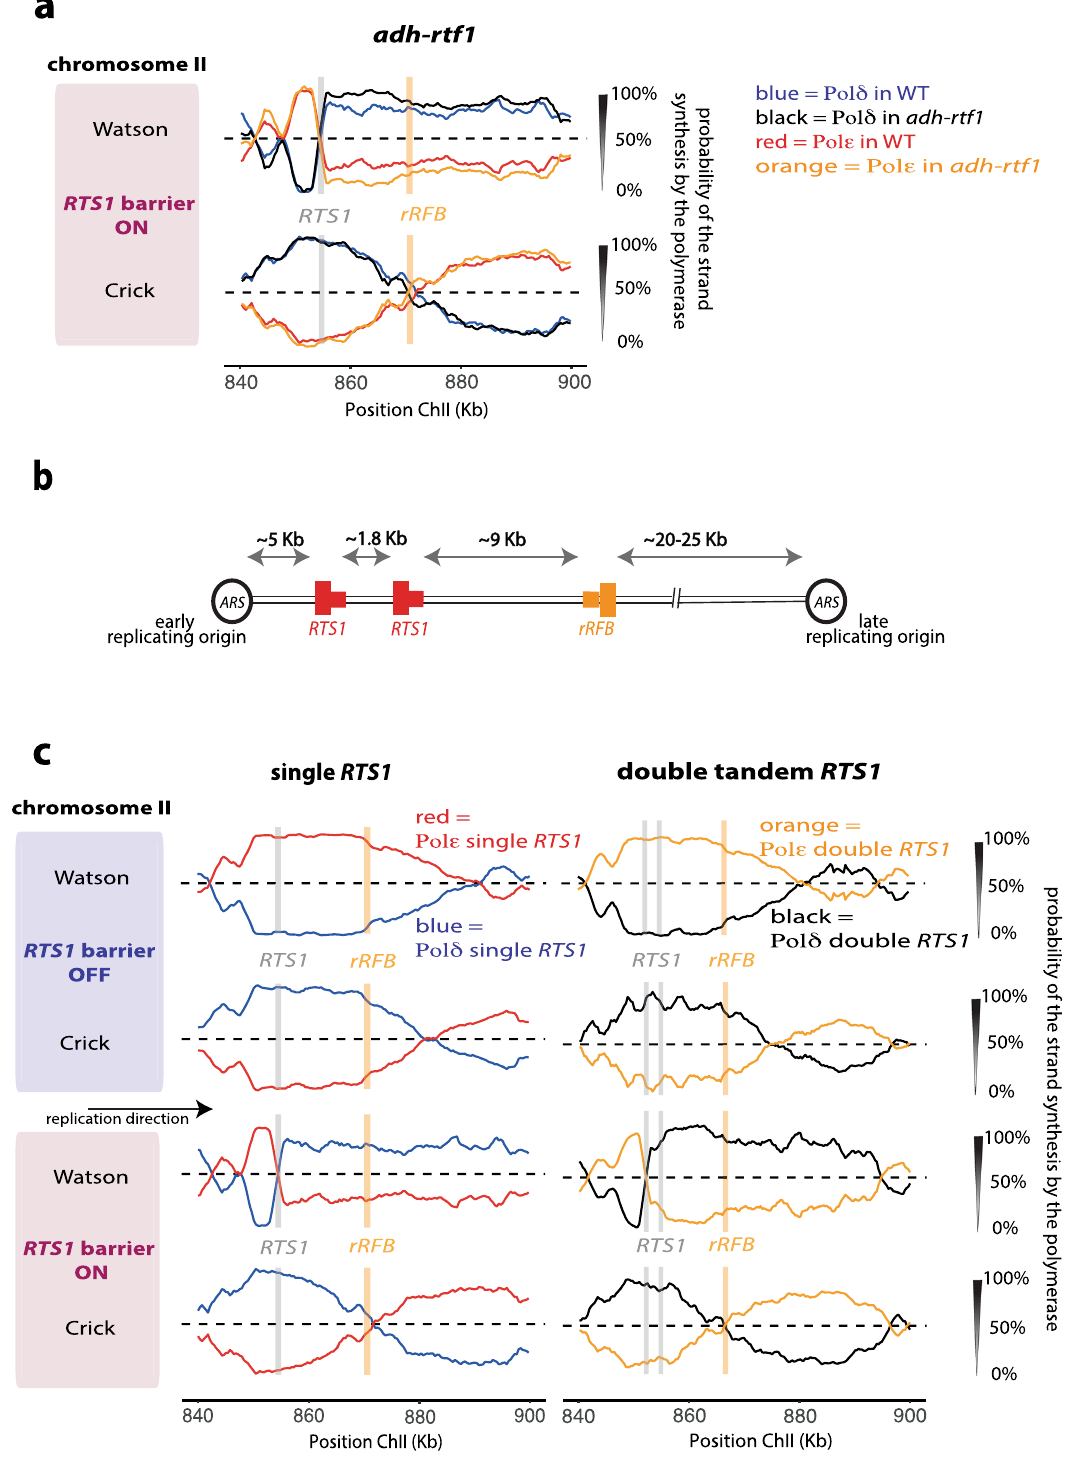
Fig. 3 HR-restarted forks are insensitive to the RTS1 barrier. a Pu-seq traces for the RTS1-rRFB locus are overlaid for two sets of strains: rtf1 + (WT), which has endogenous rtf1 expression (Pol δ : blue, Pol: ε red) and adh- rtf1 + , where expression is under control of the adh1 promoter (Pol δ : black, Pol: ε orange). b Schematic of the tandem RTS1-rRFB locus on chromosome II. The positions of the directional RTS1 and rRFB barriers are shown as red and orange, respectively with the thick bar indicating the directionality of fork arrest. ARS: autonomously replicating sequence. c Pu-seq traces for the tandem RTS1- rRFB locus which contains two copies of the RTS1 barrier that are both orientated to arrest left-right forks (right) compared to the original RTS1-rRFB locus (left). Top: barrier off. Bottom: barrier